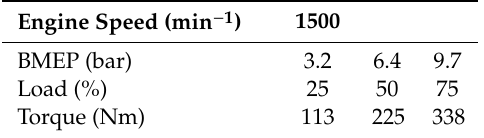
Table 3. Engine operating conditions with light fuel oil